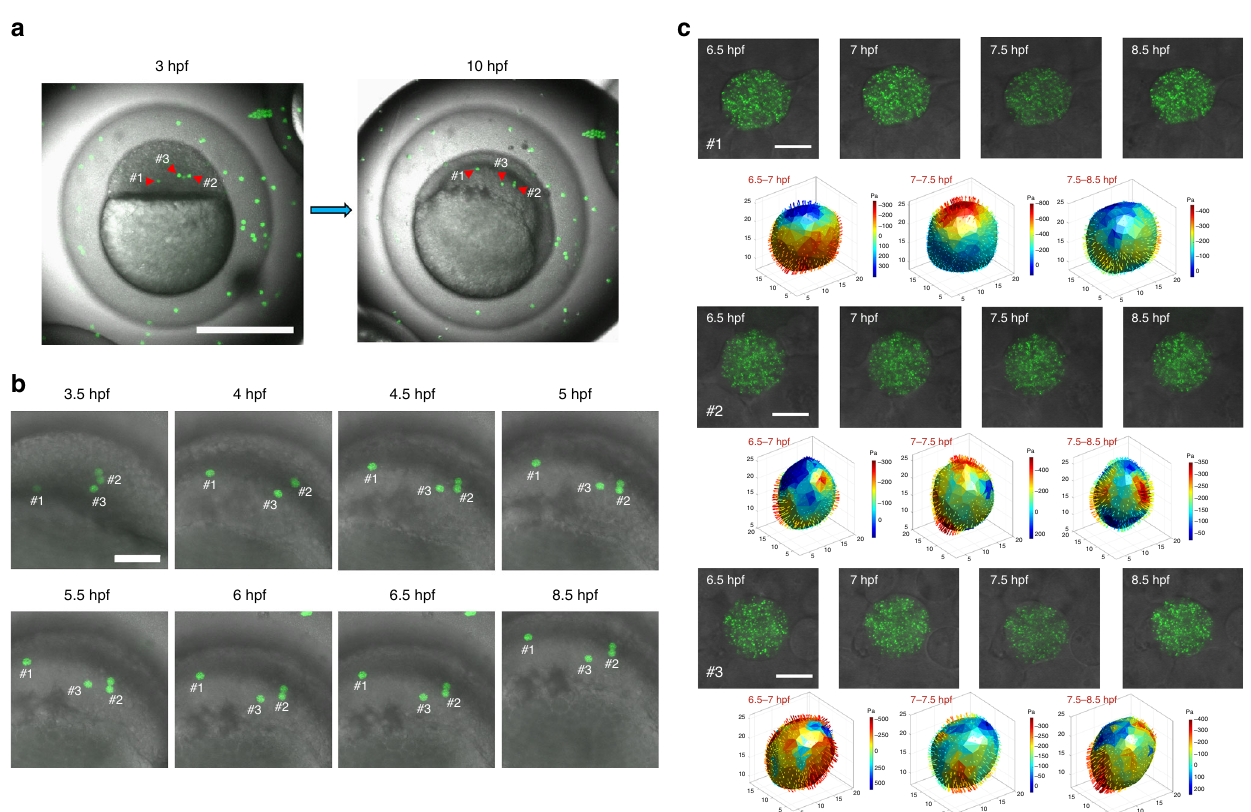
Fig. 10 Substantial spatial and temporal traction variations inside a zebra fi sh. a A developing zebra fi sh embryo from 3 to 10 hpf with numerous embedded microgels, of which #1, #2, and #3 microgels are imaged and their tractions are calculated. Scale bar, 500 μ m. b Corresponding high magni fi cation confocal sections of the three embedded microgels at different stages of development at distinct locations. A microgel near #2 microgel is too blurry such that its tractions could not be quanti fi ed. Scale bar, 100 μ m. c 3D plots of relative total tractions (changes in total tractions) for the corresponding microgels from 6.5 to 7, 7 to 7.5, and 7.5 to 8.5 hpf. For clarity, only total tractions are shown here. All scale bars, 10 μ